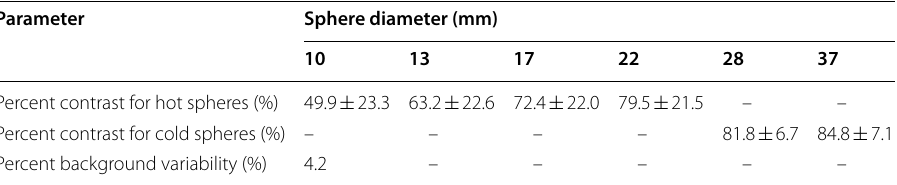
Table 2 Percent contrast and percent background variability evaluated with the brain‑size image‑ quality phantom